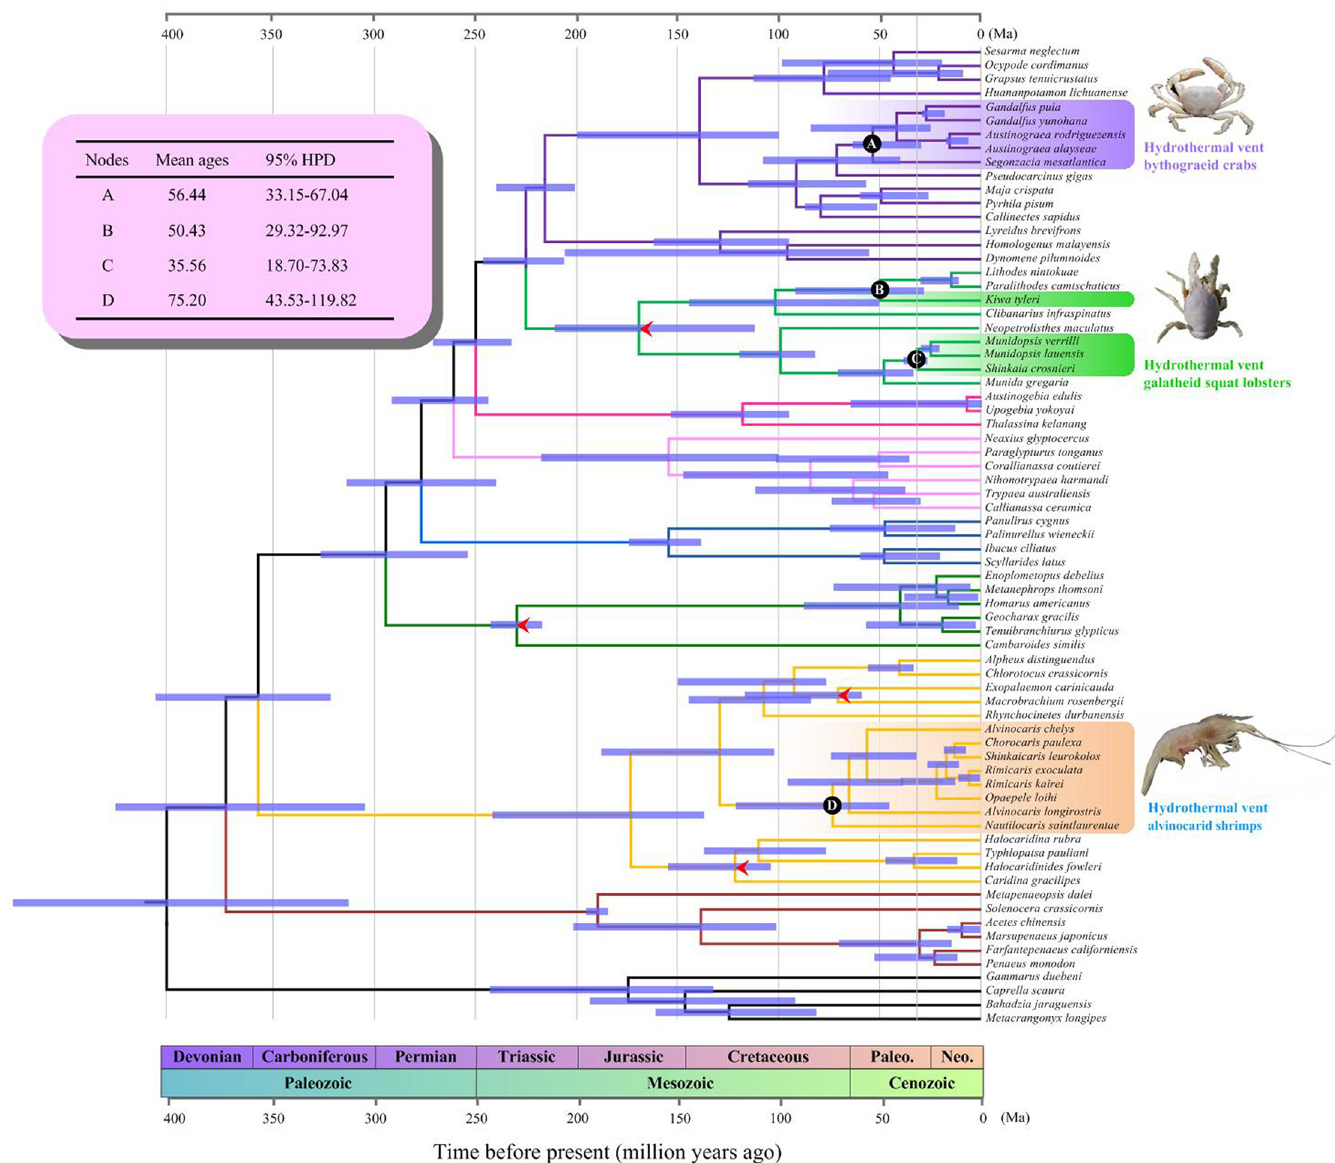
Fig 3. Estimates of divergence times using BEAST. Blue bars indicate 95% highest posterior density (HPD) intervals for nodes. The interested nodes are indicated by black circles, which correspond to the origin of hydrothermal vent bythograeid crabs (node A), galatheid squat lobsters (node B, C) and alvinocarid shrimps (node D). The mean divergence times and the 95% HPD of the interested nodes were shown on the top left corner. Species names and terminal branches are in purple, green and orange for hydrothermal vent bythograeid crabs, galatheid squat lobsters and alvinocarid shrimps, respectively. Calibrated nodes are indicated by